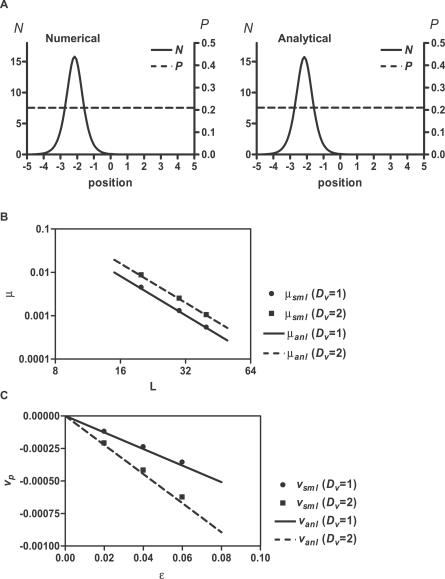
Verification of Analysis by Computations(A) Approximation of one-peak solution. The left panel indicates the result of numerical simulation (Model II); the right panel indicates the analytical approximation.(B) Instability of the two-peak solution. A two-peak state is unstable in Model II and some perturbation grows. We compare the growth rates estimated by analysis with those obtained by simulations. For simulations, we varied Dv (= 1 or 2) and L (= 20, 30, or 40); thus, six trials were performed. The axes indicate μ and L in double logarithmic scales.(C) Movement of polarized peak is dependent on the parameter gradient. An existent peak moves when a gradient is given to the parameter. We compare the velocity estimated by analysis with those obtained by simulations. For simulations, we varied Dv (= 1 or 2) and ɛ (= 0.02, 0.04, or 0.06); thus, six trials were performed.